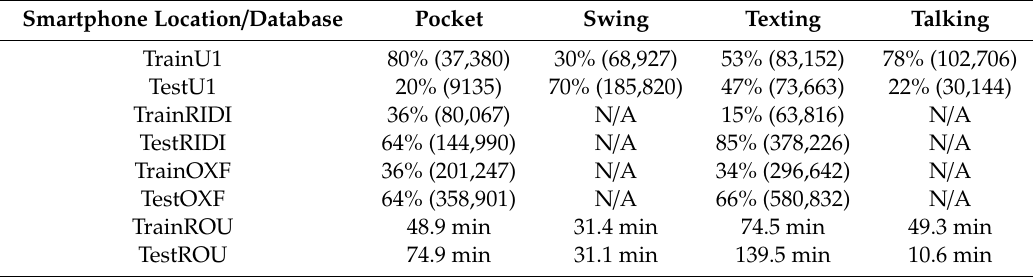
Figure 10. The angular velocity magnitude for a smartphone in the pocket mode as recorded for three users, each from a different dataset—RIDI, OXF, and U1. Table 3. Samples and corresponding time distribution of each smartphone location in the two types of training modes’ datasets. The percentage is the ratio from the original dataset and the parentheses show the number of